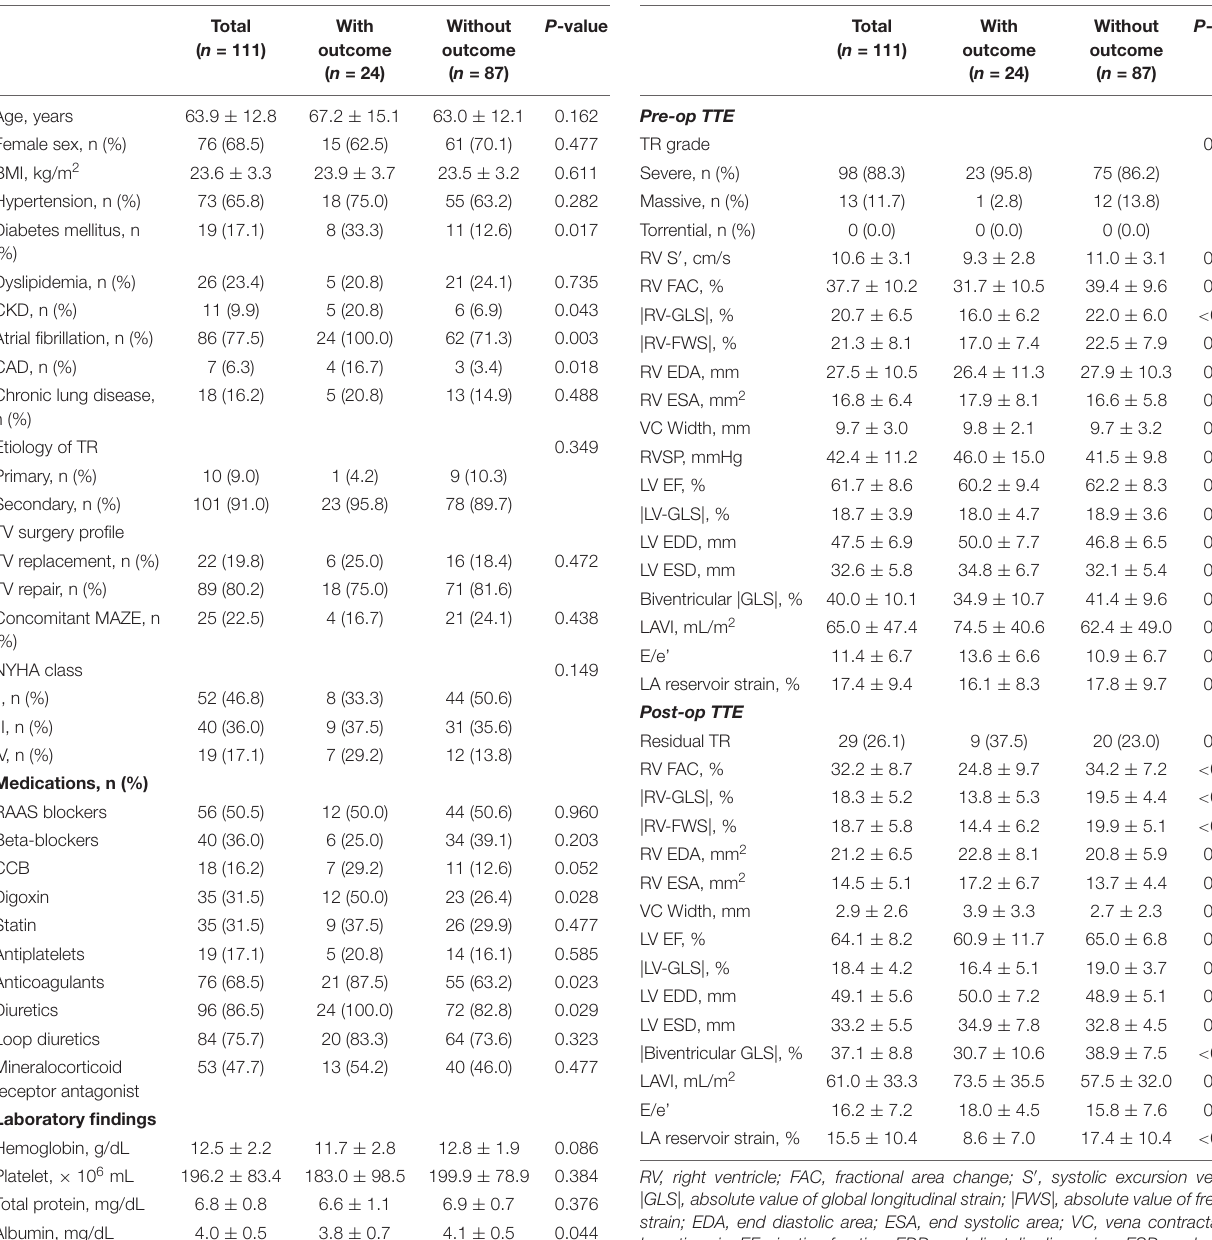
TABLE 1 | Baseline characteristics. TABLE 2 | Echocardiographic characteristics.